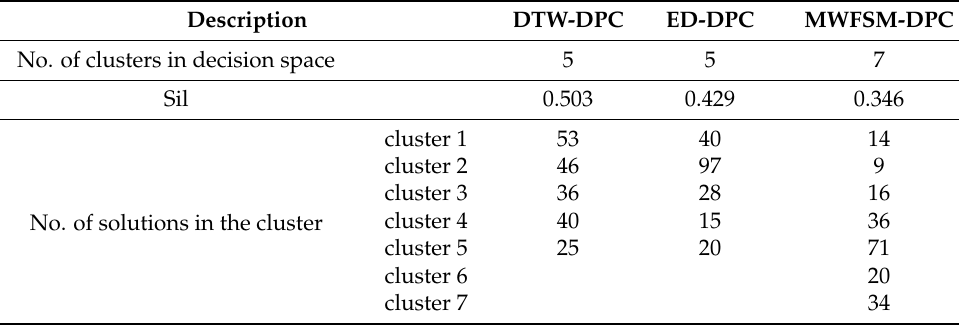
Table 1. Results obtained via clustering in decision space. Description DTW-DPC ED-DPC